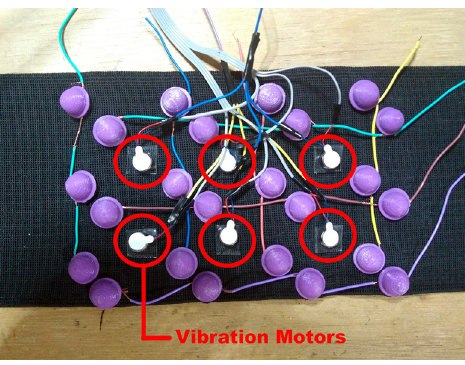
Figure 9: Six vibration motors were added to the set of electrodes.